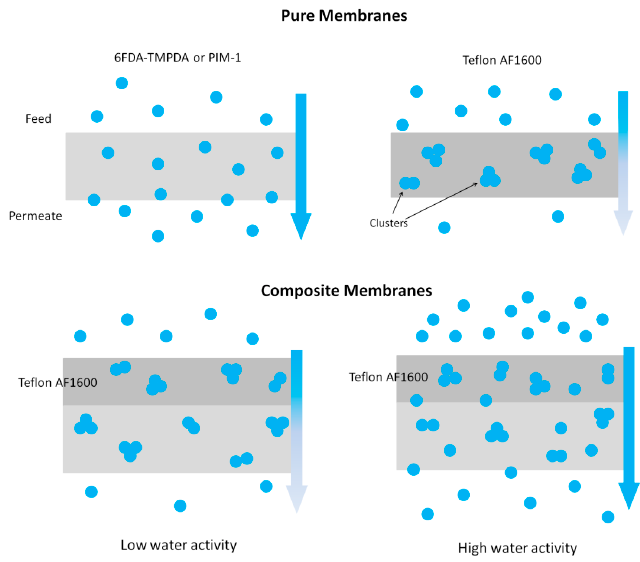
Figure 1. Schematic of water transport through the respective individual and composite membranes.